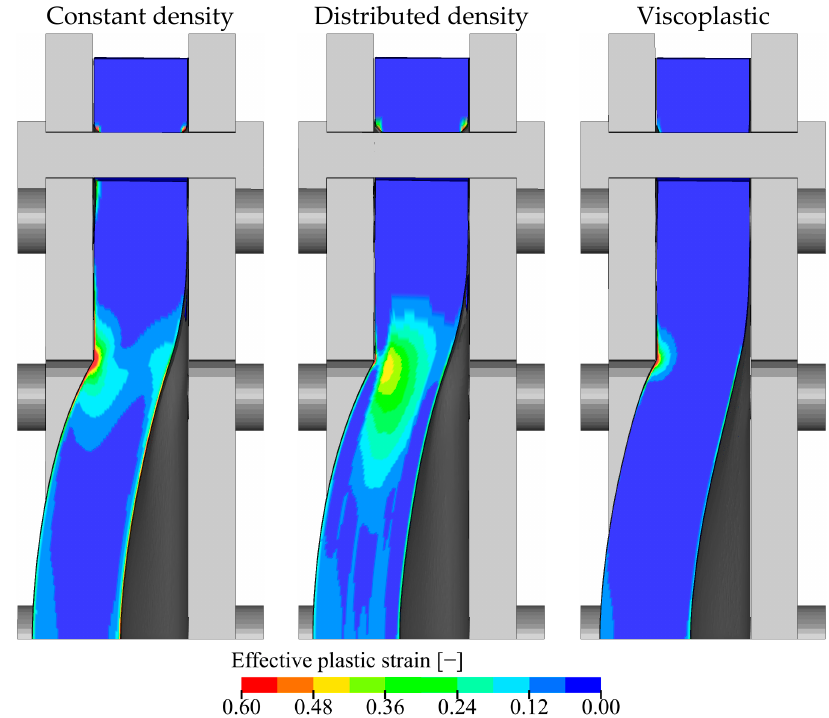
Figure 23. Deformation profiles and plastic strain fields from numerical simulations of test Sw_400_P10.